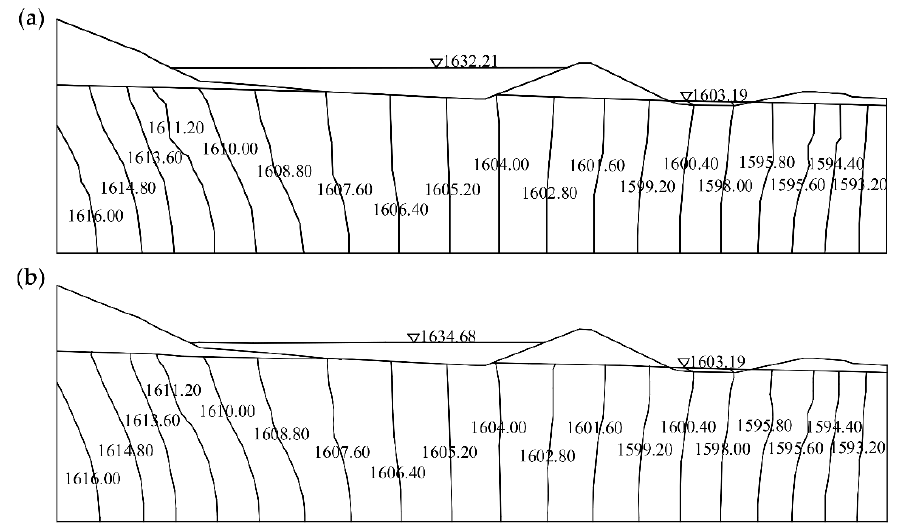
Figure 9. Potential distributions of the seepage field at a typical cross-section of the dam body: ( a ) in normal water level conditions; ( b ) in the designed flood level conditions.